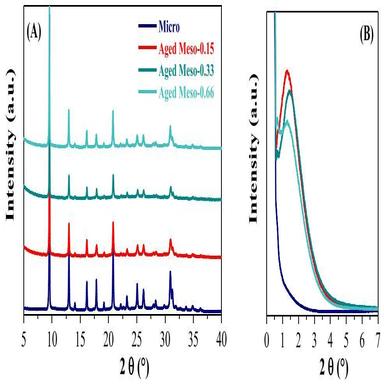
XRD patterns (A) wide- and (B) low-angles of conventional micropores CHA-based zeolite and hierarchical SAPO-34 CHA-based zeolites synthetized with different amount of CTAB.